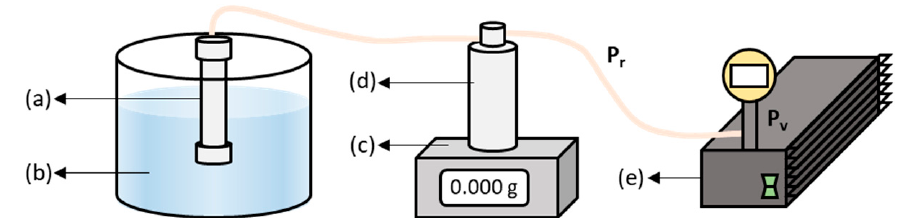
Figure 1. Permeability system consisting on: ( a ) membrane, ( b ) solution reservoir, ( c ) weight balance, ( d ) vacuum trap and ( e ) vacuum pump.